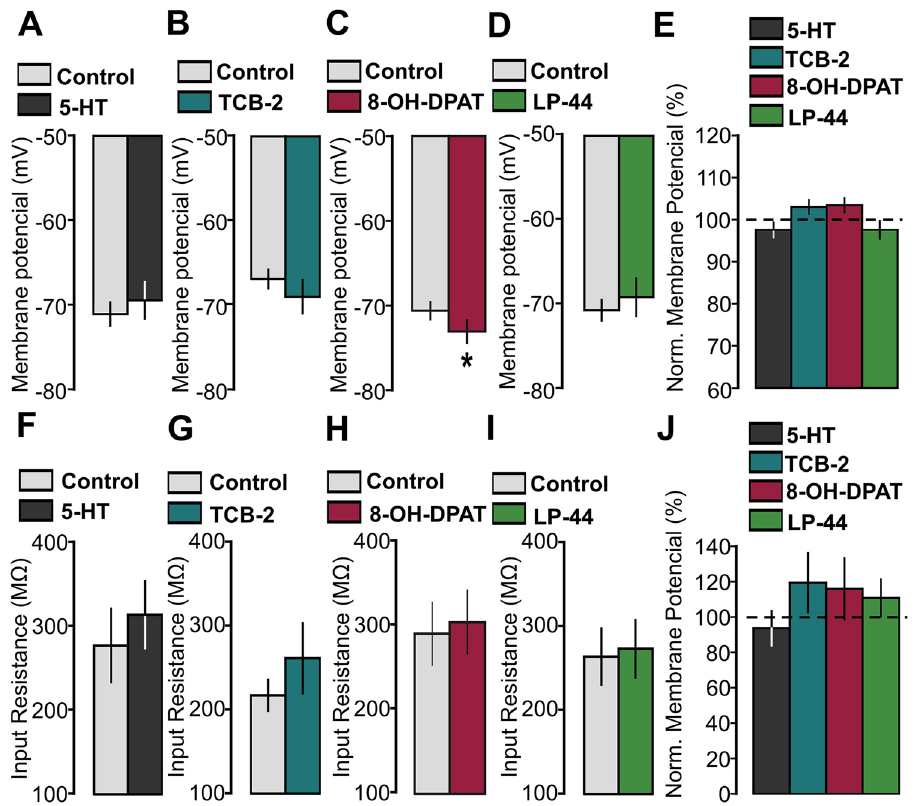
Figure 9. 5-HT and the 5-HT 1A/2A/7 receptors agonists have no effect on neuronal excitability. ( A ) Graph showing the averaged membrane resting potential recorded in the control condition (before the drug application, for 5 min) and under the effect of 5-HT (50 µM, from 25 to 30 min after the drug application). ( B ) Graph showing the averaged membrane resting potential recorded in the control condition (before the drug application, for 5 min) and under the effect of TCB-2 (10 µM, from 25 to 30 min after the drug application). ( C ) Graph showing the averaged membrane resting potential recorded in the control condition (before the drug application, for 5 min) and under the effect of 8-OH-DPAT (1 µM, from 25 to 30 min after the drug application). ( D ) Graph showing the averaged membrane resting potential recorded in the control condition (before the drug application) and under the effect of LP-44 (2 µM, from 25 to 30 min after the drug application). ( E ) Graph showing the averaged membrane resting potential recorded under the effect of 5-HT and 5-HT 1A/2A/7 agonists (from 25 to 30 min after the drug application). Four experimental groups are compared: 5-HT (50 µM), TCB-2 (10 µM), 8-OH-DPAT (1 µM) and LP-44 (2 µM). EPSPs values were normalized to the mean of membrane resting potential values recorded before the drug application, for 5 min. ( F ) Graph showing the averaged input resistance recorded in the control condition (before the drug application, for 5 min) and under the effect of 5-HT (50 µM, from 25 to 30 min after the drug application). ( G ) Graph showing the averaged input resistance recorded in the control condition (before the drug application, for 5 min) and under the effect of TCB-2 (10 µM, from 25 to 30 min after the drug application). ( H ) Graph showing the averaged input resistance recorded in the control condition (before the drug application, for 5 min) and under the effect of 8-OH-DPAT (1 µM, from 25 to 30 min after the drug application). ( I ) Graph showing the averaged input resistance in the control condition (before the drug application, for 5 min) and under the effect of LP-44 (2 µM, from 25 to 30 min after the drug application). ( J ) Graph showing the averaged input resistance recorded under the effect of 5-HT and 5-HT 1A/2A/7 agonists (from 25 to 30 min after the drug application). Four experimental groups are compared: 5-HT (50 µM), TCB-2 (10 µM), 8-OH-DPAT (1 µM) and LP-44 (2 µM). EPSPs values were normalized to the mean of input resistance values recorded before the drug application, for 5